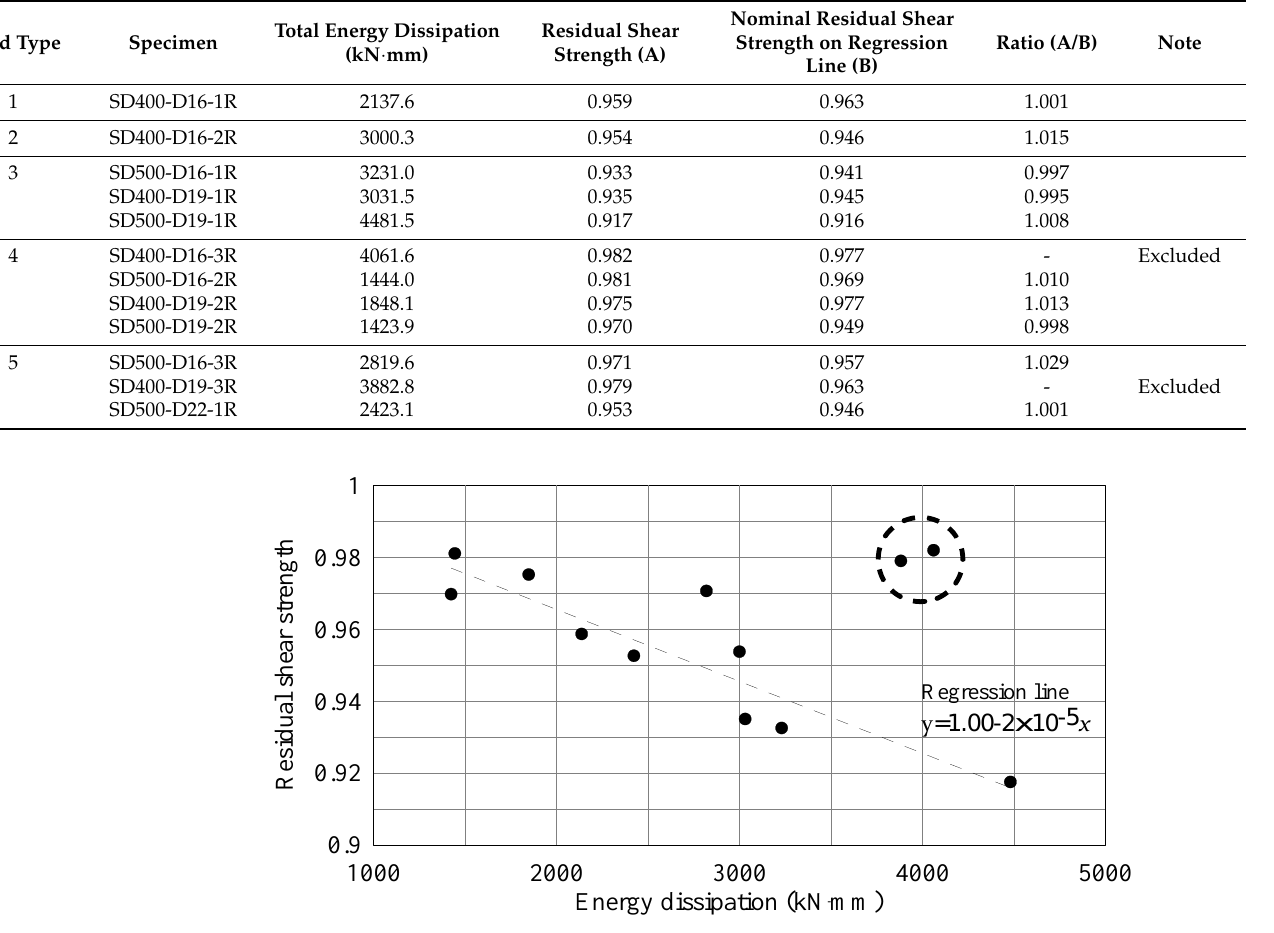
Figure 14. Distribution of residual shear strength and energy dissipation.